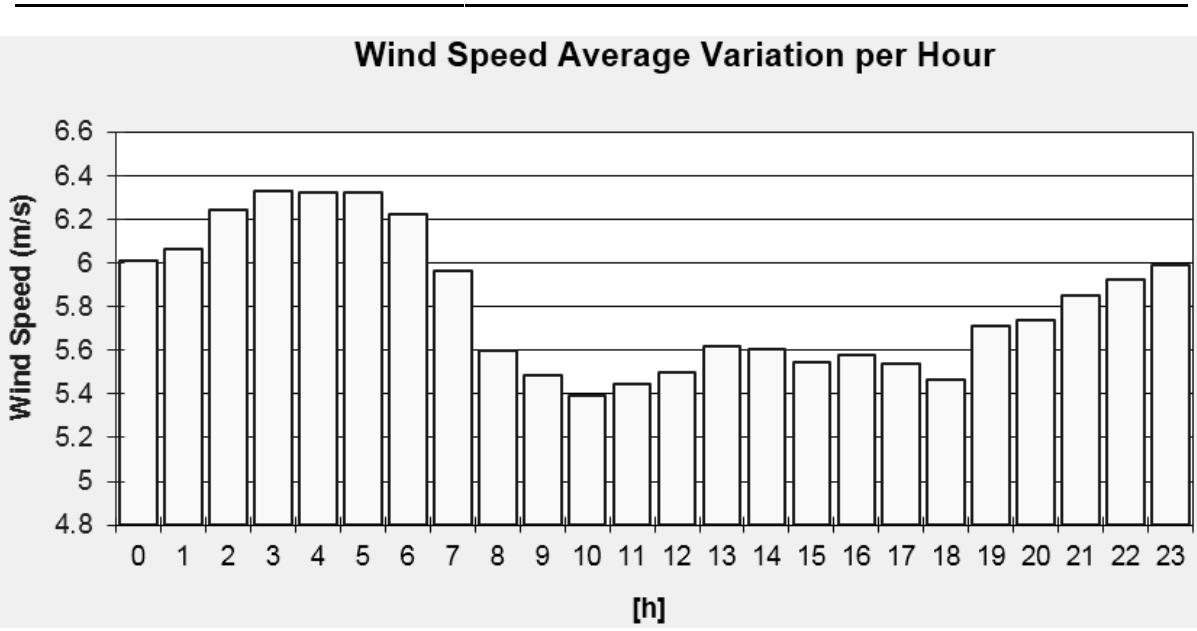
Figure 1. Wind Speed Average Variation per